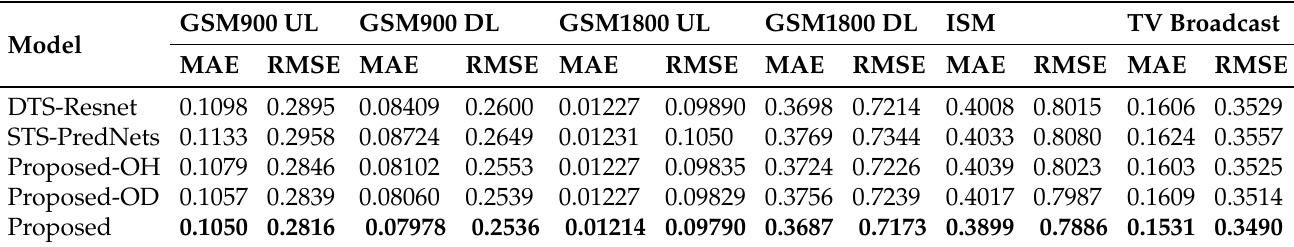
Table 4. Prediction performance of the model based on multi-timescale